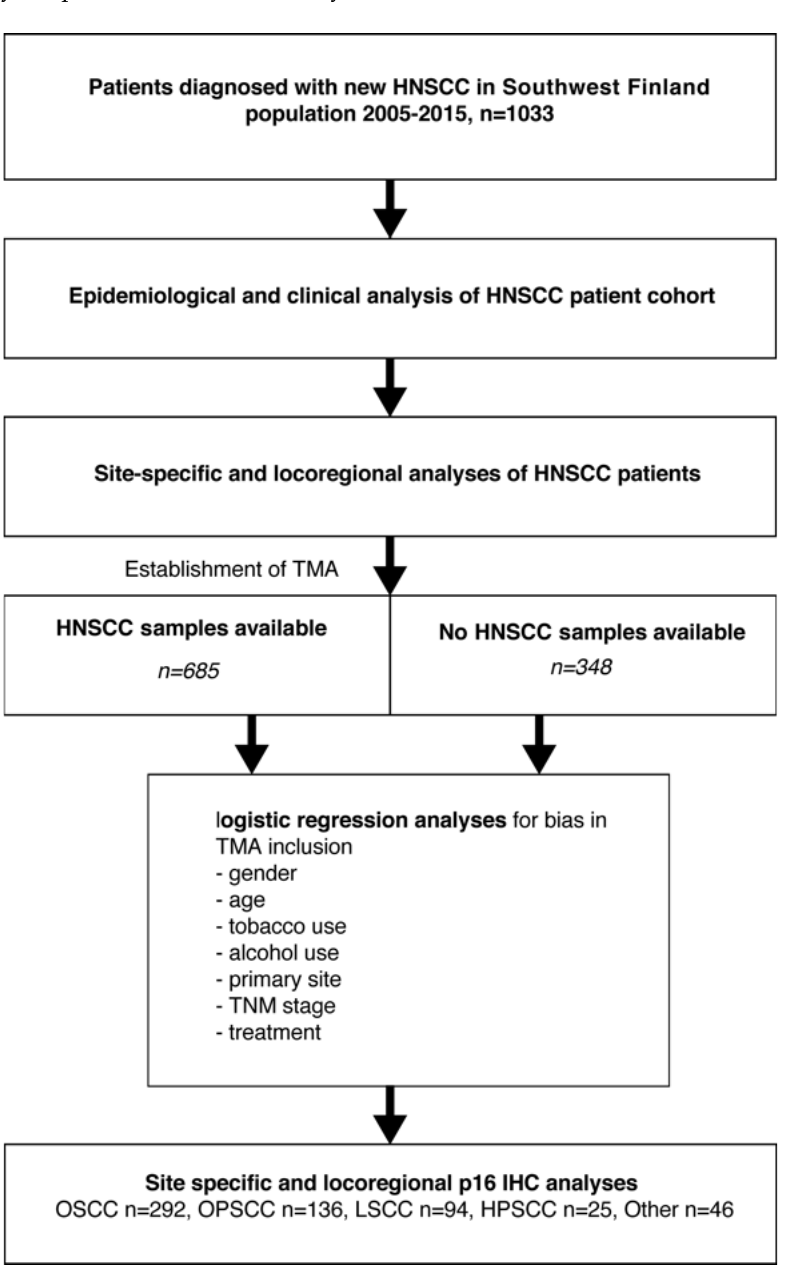
Figure 1. The study protocol for the identification and analysis of all patients with new HNSCC in the Southwestern Finland region from 2005–2015 ( n = 1033). The same clinical cohort was used in the formation of an unbiased and population-validated HNSCC tissue microarray (TMA) archive for p16